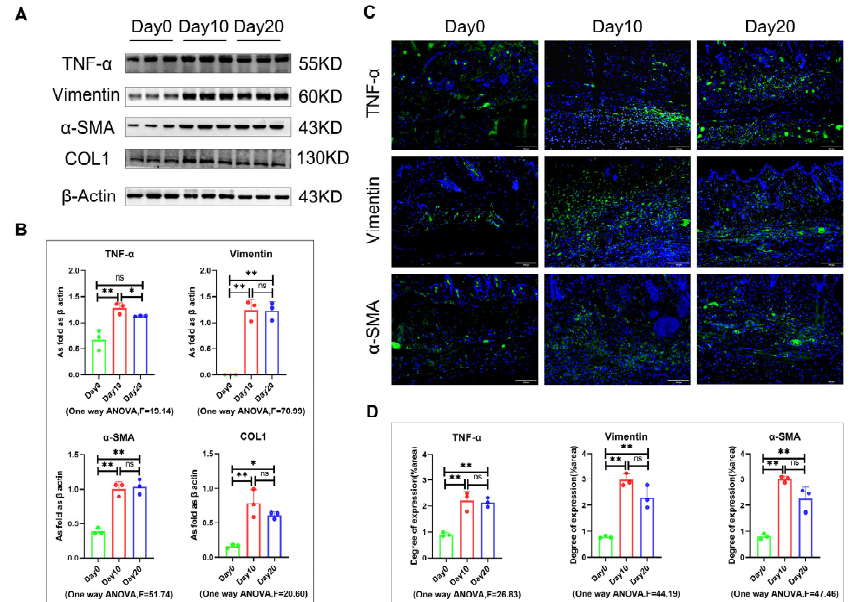
Figure 9. ( A , B ) Western blotting detected the relative protein expression levels of TNF- α , vimentin, α -SMA, and COL1 in the skin of mice on days 0, 10, and 20. ( C , D ) Immunofluorescence method to detect the relative expression levels of TNF- α , vimentin, and α -SMA in mouse skin. Data are presented as the mean ± SD; n = 3 for each group. * p < 0.05, ** p < 0.01.